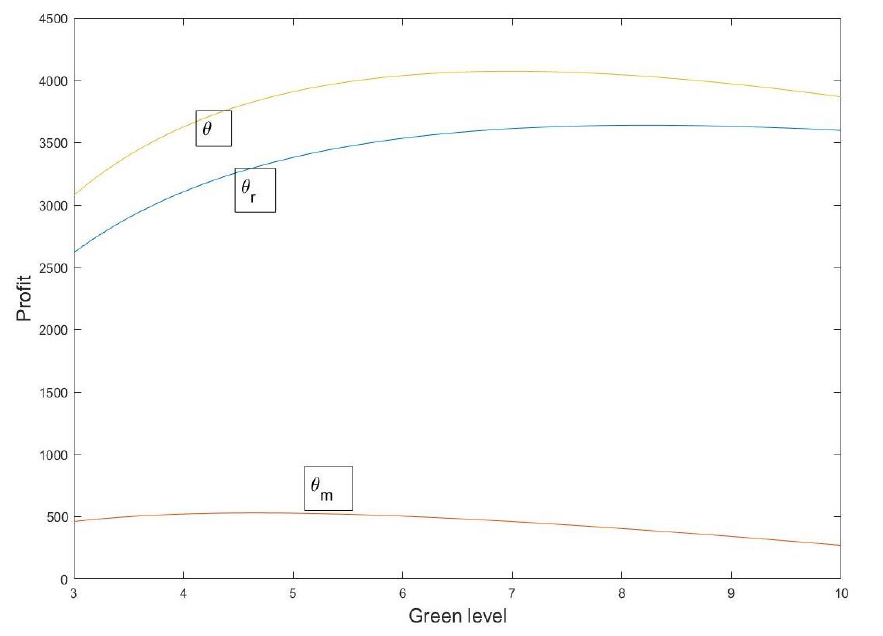
Figure 5. Graphical representation of changes of profit with